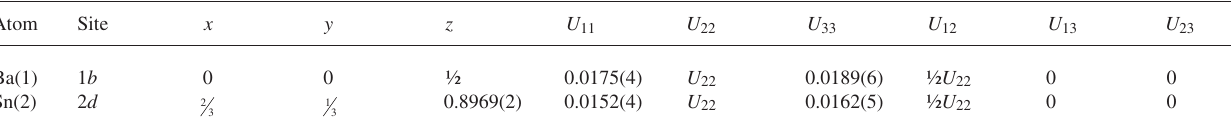
Table 2. Atomic coordinates and displacement parameters (in Å 2 ) .